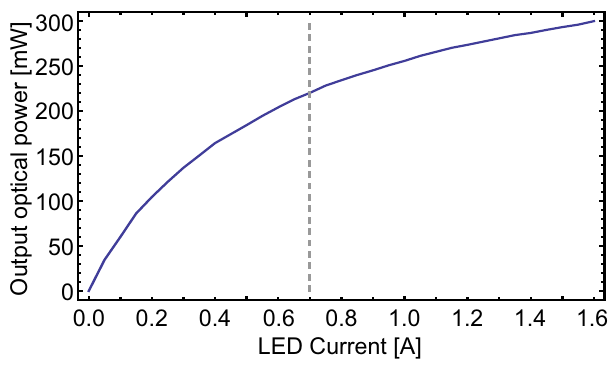
Figure 2. Measured light emission directly in front of light-emitting diode mounted in the diode assembly. The dashed line shows the nominal maximal current of 700 mA.